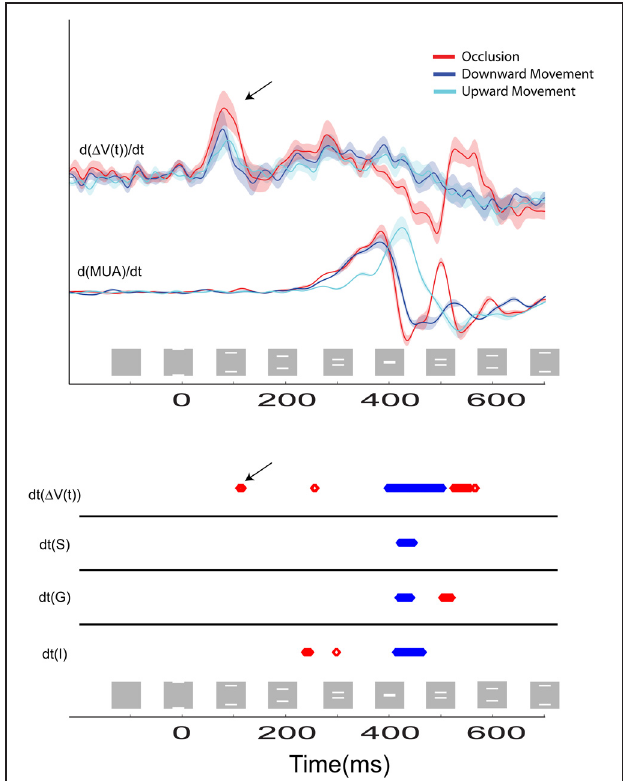
FIGURE 6 | The time course of the temporal derivatives for the three stimulus conditions are shown. Top : the d[ (cid:3) V ( t ) ]/dt and the d(MUA)/dt. Bold lines indicate the mean values for N = 14 and N = 10 animals, respectively, and the shaded regions indicate standard error of mean (SEM). Recordings were taken from the cortical site representing the center of field of view at the 17/18 border. The first positive peak at 85ms is due to the directional pre-excitation ahead of the moving bar representation. Bottom : Statistical comparison of the amplitude of the response for the occlusion condition compared to the amplitude of the response for the single bar conditions for the d[ (cid:3) V ( t ) ]/dt and the d(MUA)/dt recorded from supragranular (S), granular (G), and infragranular (I) cortical layers at the site representing the center of field of view. Epochs where the amplitude of these variables during the occlusion condition is significantly greater than the amplitude of the variables to either of the two single bar conditions are shown in red, and epochs where the amplitude of the variables to the occlusion condition is significantly less than the amplitude of responding to either of the single bar conditions are shown in blue ( p < 0 . 01). Note that when the first effect of the excitatory synaptic activity reaches the area 17/18 border at 120ms, the d (cid:3) V ( t ) /dt becomes statistically significantly stronger than in the single bar conditions (black arrows Top and Bottom